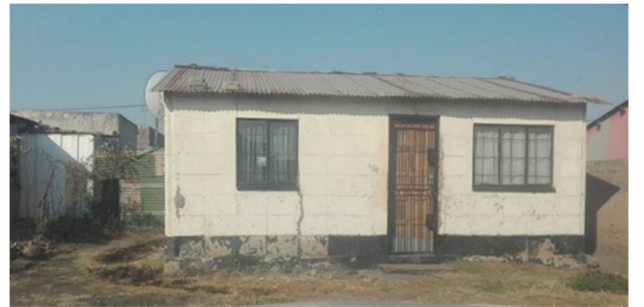
Figure 2. Floor plan of a common South African RDP home ( a ); in the last approximately 20 years RDP homes now include wall partitions creating two bedrooms, walls are made from cement brick ( b ), older homes are made with the more compact (150 mm × 100 mm) brick and newer homes (built after 1999) with the larger (200 mm × 400 mm) brick. The larger cement brick commonly is not filled with any insulating material. The homes have a U-value of 49.37 W / m 2 ◦ K (both old and recent RDPs). The RDPs that were sampled have a comparable surface area to apartheid era matchbox houses (sourced from: Moolla et al. [14]).